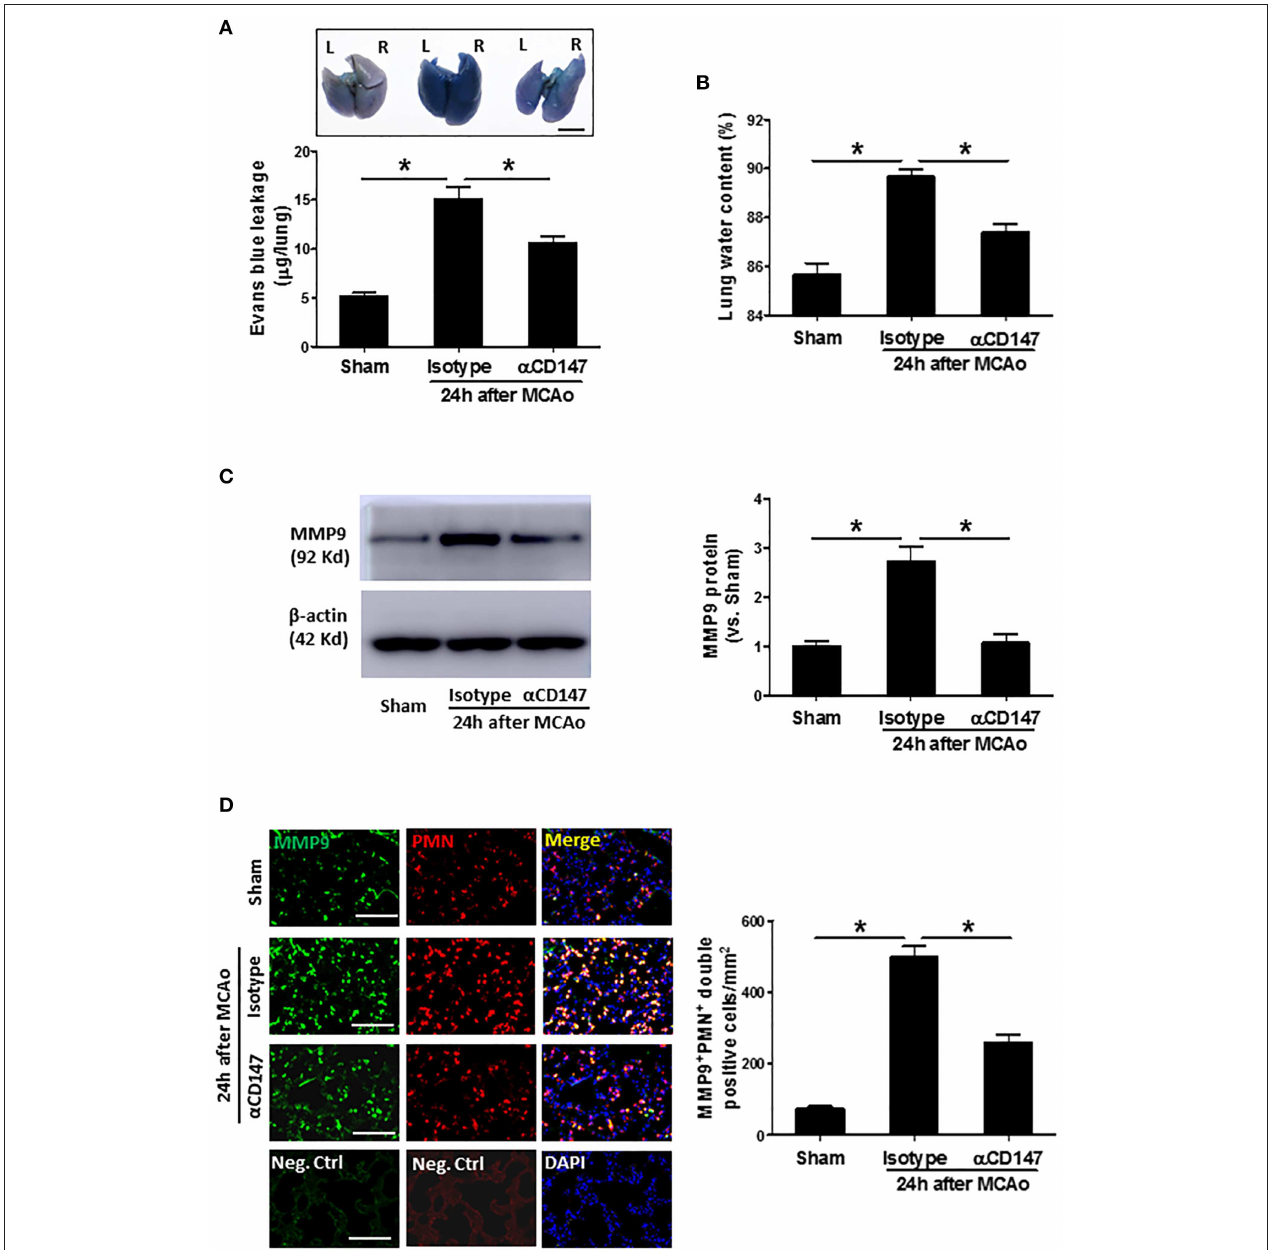
FIGURE 2 | Inhibition of CD147 attenuates post-stroke lung vascular permeability and edema through inhibition of MMP-9 activity. (A) Representative pictures and quantitative analysis of Evans blue leakage in the lung tissue at 24h after stroke. L: left lung (one lobe), R: right lung (four lobe). Bar = 5mm. n = 6 per group. (B) Lung water content at 24h after stroke. n = 6 per group. (C) Representative images of western blots showing MMP-9 protein levels in the lung tissues and semi-quantitative analysis of immunoblots. n = 4 per group. (D) Double immunostaining for MMP-9 and neutrophils in the lung sections in indicated groups at 24h after stroke (left panel). Neg.Ctrl indicates negative control. Bar = 100 µ m. The number of the cells double positively stained for neutrophils and MMP-9 per mm 2 was counted (right panel). n = 6–7 per group. * P <